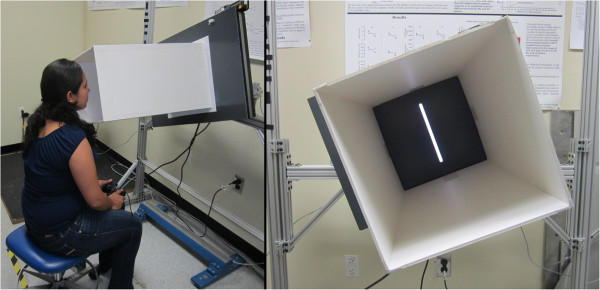
Rod and Frame test.